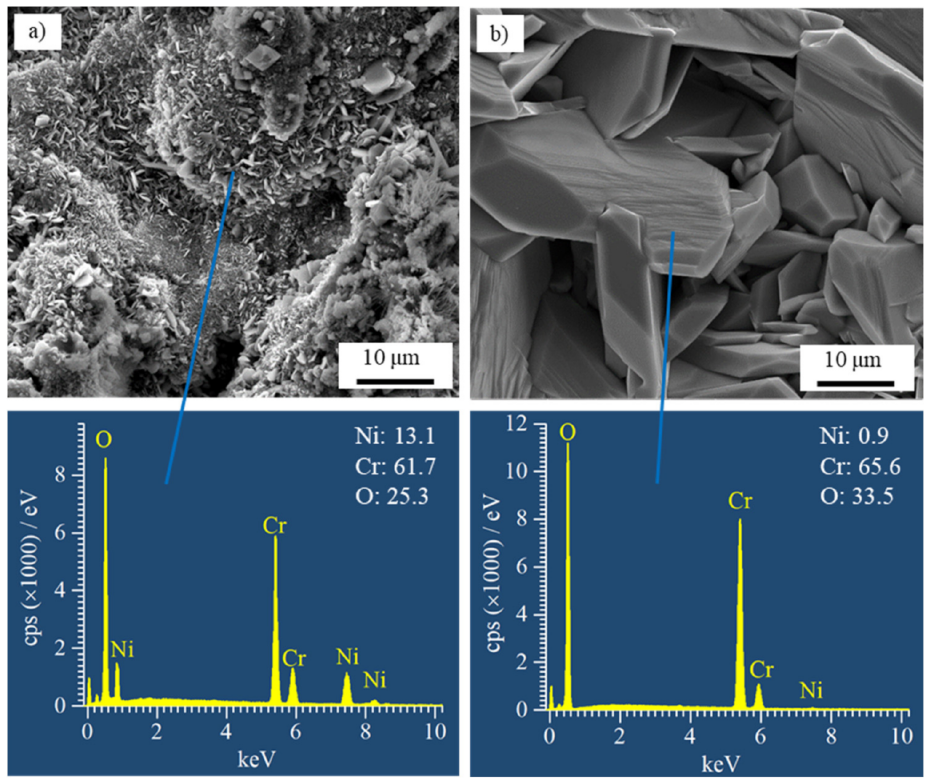
Figure 6. SE SEM images of the surfaces and EDS results of ( a ) NiCrB and ( b ) NiCrTi coatings prepared by air atomization after the hot corrosion